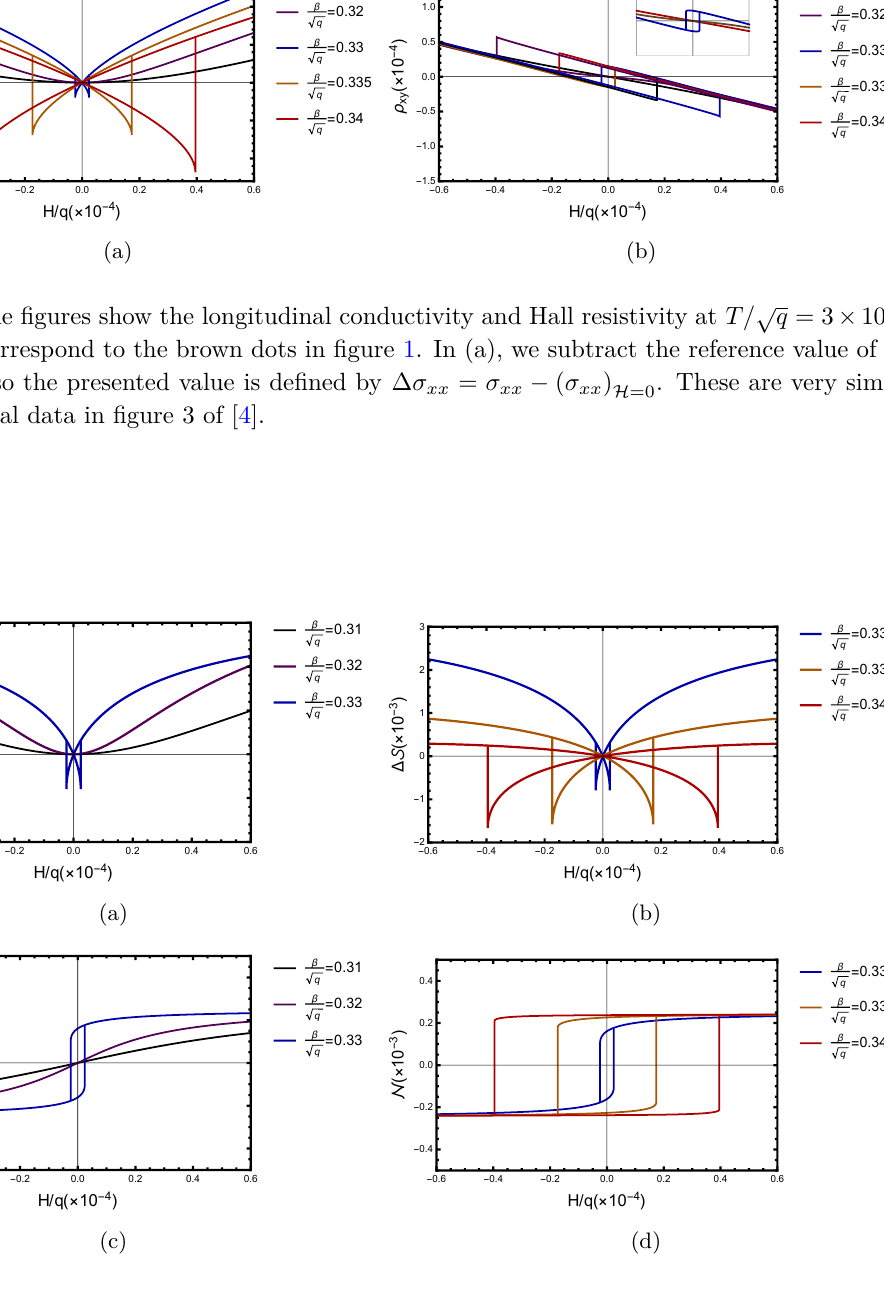
Figure 3 . This figures show the Seebeck and the Nernst coefficients with T/ the brown dots in figure 1. Here we subtracted the reference value for the Seebeck coefficient ( ∆ S ≡ S − ( S ) ). These are our novel predictions which can be checked by experiments. H =0